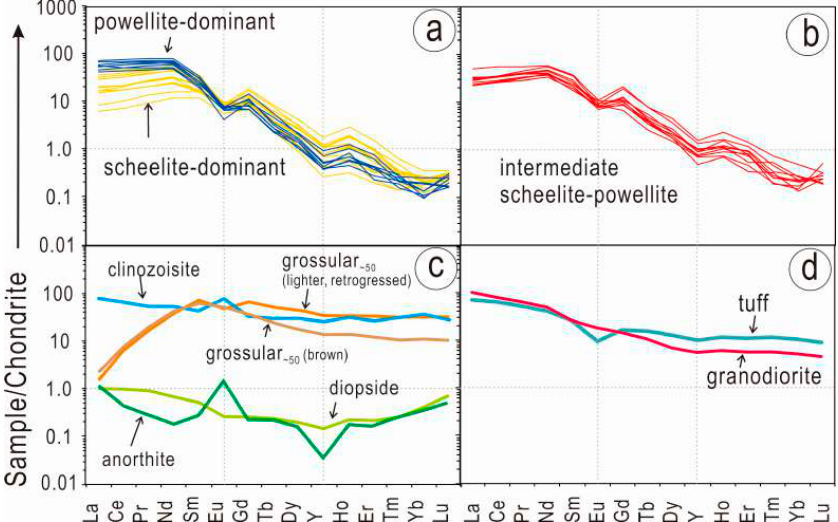
Figure 6. Chondrite-normalized REY fractionation trends for scheelite-powellite ( a , b ; individual analyses Table 2) and for skarn minerals in the same sample (#168; averages from Xu et al. [22]) in ( c ) and for lithologies (whole rock data; Xu et al. [20] in ( d )). Note the change in the patterns towards higher LREE in powellite-dominant areas in ( a ). Grossular (Gr ~50 ) and clinozoisite (in ( c )) are main REE carriers for the prograde and retrograde stages, respectively. Note the MREE-rich trend in Gr ~50 and its marked variation with colour/retrograde stage. Trends for the two lithologies are relatively similar except the negative Eu anomaly in the tuff, shown in ( d ).